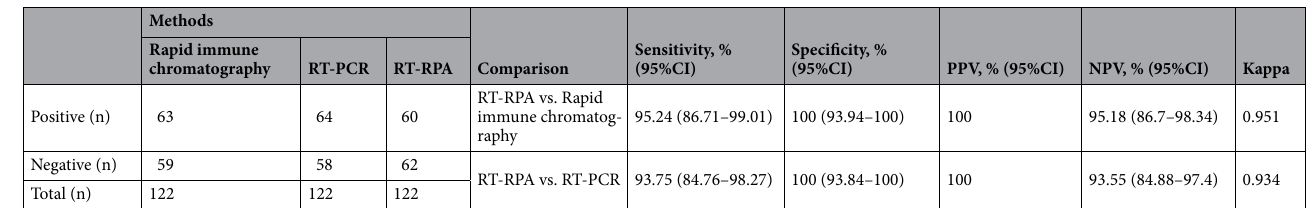
Table 4. Validation of clinical samples for FeLV testing by rapid immunochromatography, RT-PCR, and